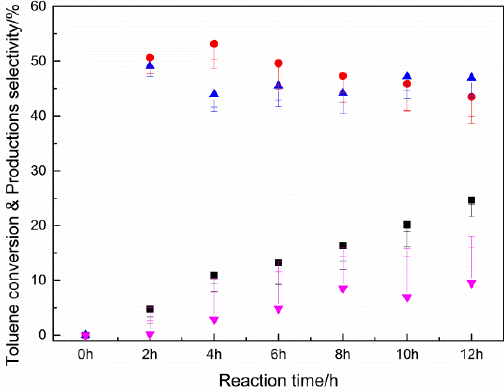
Figure 6. Catalytic performance for the selective oxidation of toluene on the Mn 3 O 4 /CNTs-3 with different reaction times.